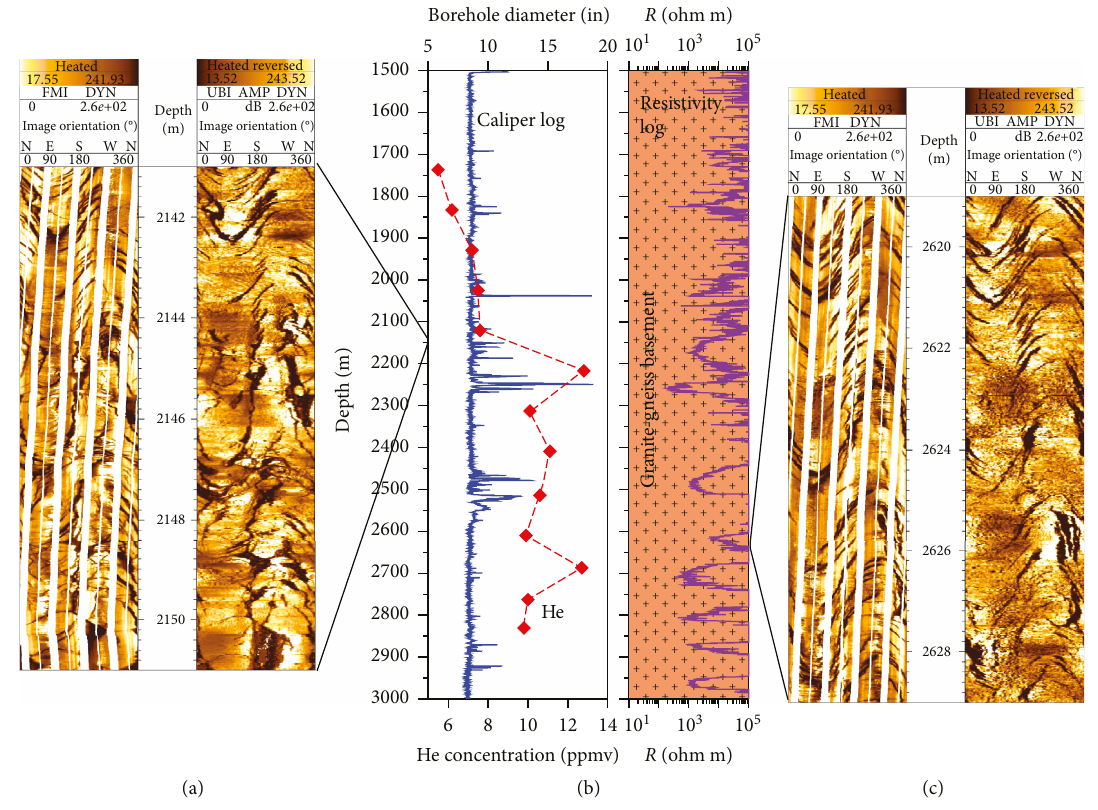
Figure 7: Plots showing downhole electrical resistivity (purple line) and calliper (blue line) logs along with helium concentration from QMS measurements (red diamonds) in the granitic basement section 1500-3000 m in the borehole KFD1. High resolution electrical (FMI) and acoustic (UBI) images of two typical depth sections 2141-2151m (a) and 2619-2629m (c) showing highly fractured basement rocks corresponding to zones of helium enhancements are also